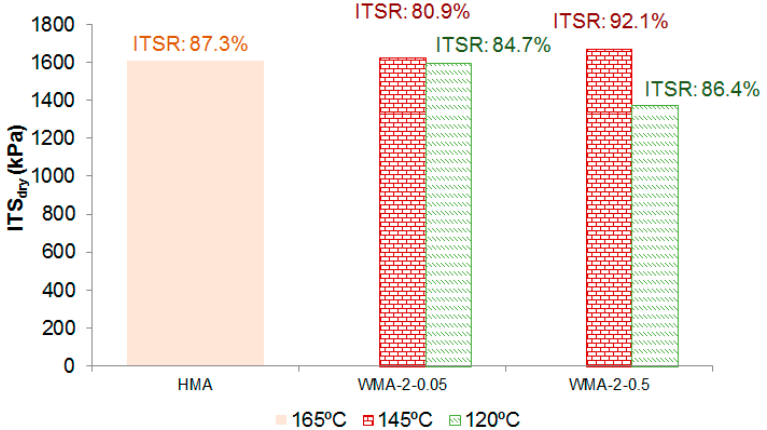
Figure 6. ITS (Indirect Tensile Strength) and water sensitivity results for the HMA and WMA with different quantities of additive under various manufacturing temperatures.